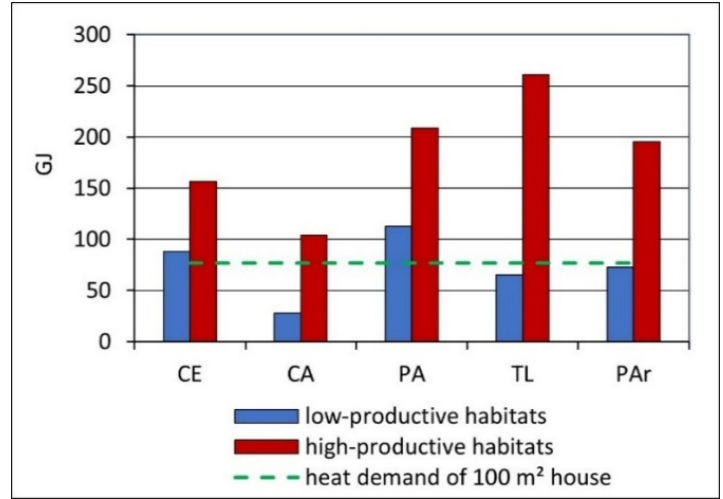
Figure 5. Heat supply from biomass combustion: Comparison of less productive and highly productive (paludiculture) habitats. CE— Carex elata; CA— Carex acutiformis + Carex elata ; PA— Phragmites australis ; TL— Typha latifolia ; PAr— Phalaris arundinacea .